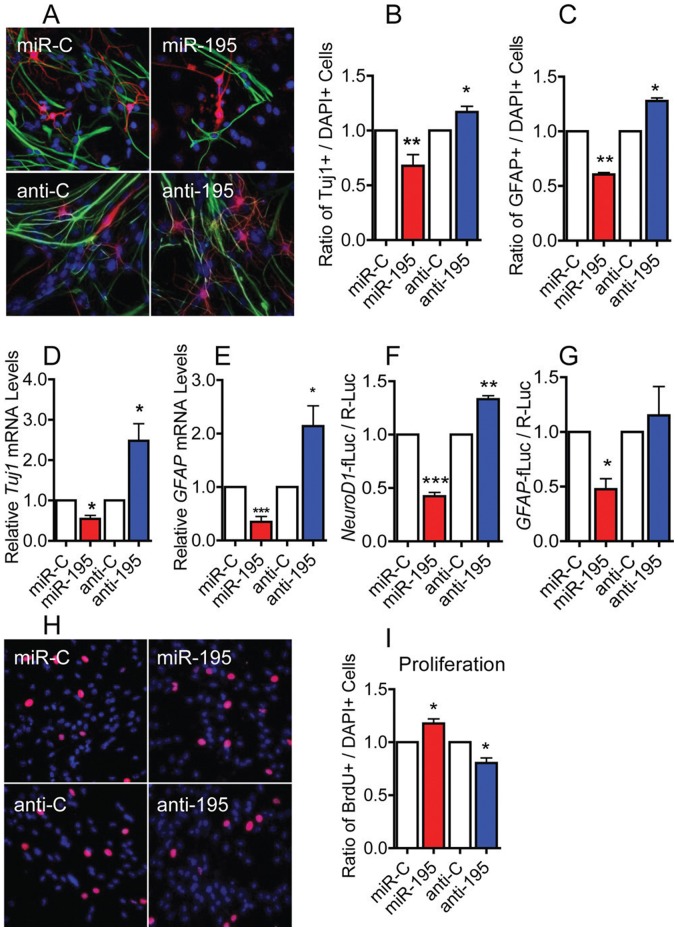
miR-195 modulates the differentiation and proliferation of adult NSCs in vitro.(A) DG-aNSCs were transfected with either synthetic miR-195 mimics or control miRNA mimics (miR-C), and aNSC differentiation was analyzed using neuronal lineage marker Tuj1 (red) and astrocyte lineage marker GFAP (green). DAPI, blue. (B, C) DG-aNSCs transfected with miR-195 mimics led toreduced neuronal (B, n = 4, p<0.5) and astrocyte (C n = 3, p<0.5)) differentiation, compared to cells transfected with miR-C. On the other hand, DG-aNSCs transfected with a specific inhibitor to miR-195 (anti-195) led to increased neuronal (B) and astrocyte (C) differentiation, compared to cells transfected with Anti-C. (D, E), aNSCs transfected with miR-195 exhibited reduced neuronal (D) and astrocyte (E) differentiation, whereas aNSCs transfected with anti-195 had increased neuronal (D) and astrocyte (E) differentiation as assessed via real-time PCR analyses for mRNA levels of neuronal gene Tuj1 (D) and astrocyte gene GFAP (E). (n = 6 to 8, P<0.05). (F, G), aNSCs transfected with miR-195 exhibited reduced neuronal (F) and astrocyte (G) differentiation, whereas aNSCs transfected with anti-195 had increased neuronal (F) and astrocyte (G) differentiation as assessed by the promoter activities of NeuroD1 (F, for neurons, n = 3 for miR; n = 5 for anti-miR, p<0.01) and GFAP (G, for astrocytes n = 4, p<0.05 for miR). (H) DG-aNSCs were transfected with either miR-195 mimics or miR-C, and aNSC proliferation was analyzed using BrdU labeling (red = DAPI, blue. (I). Quantitative analysis indicates that miR-195-transfected aNSCs had increased BrdU incorporation, compared to miR-C–transfected cells (n = 8 for miR; n = 6 for anti-miR, p<0.05). On the other hand, anti-195-transfected aNSCs displayed reduced BrdU incorporation compared to anti-Control transfected aNSCs (n = 9; p<0.05). Data are presented as mean ± SEM; *, p<0.05, **, p<0.01, One-sample t-test was used for data analyses.